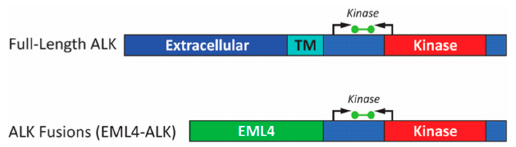
(1.7%). The group of patients whose tumors were ALK-positive by RT-PCR, IHC and FISH contained 76% never or light smokers.